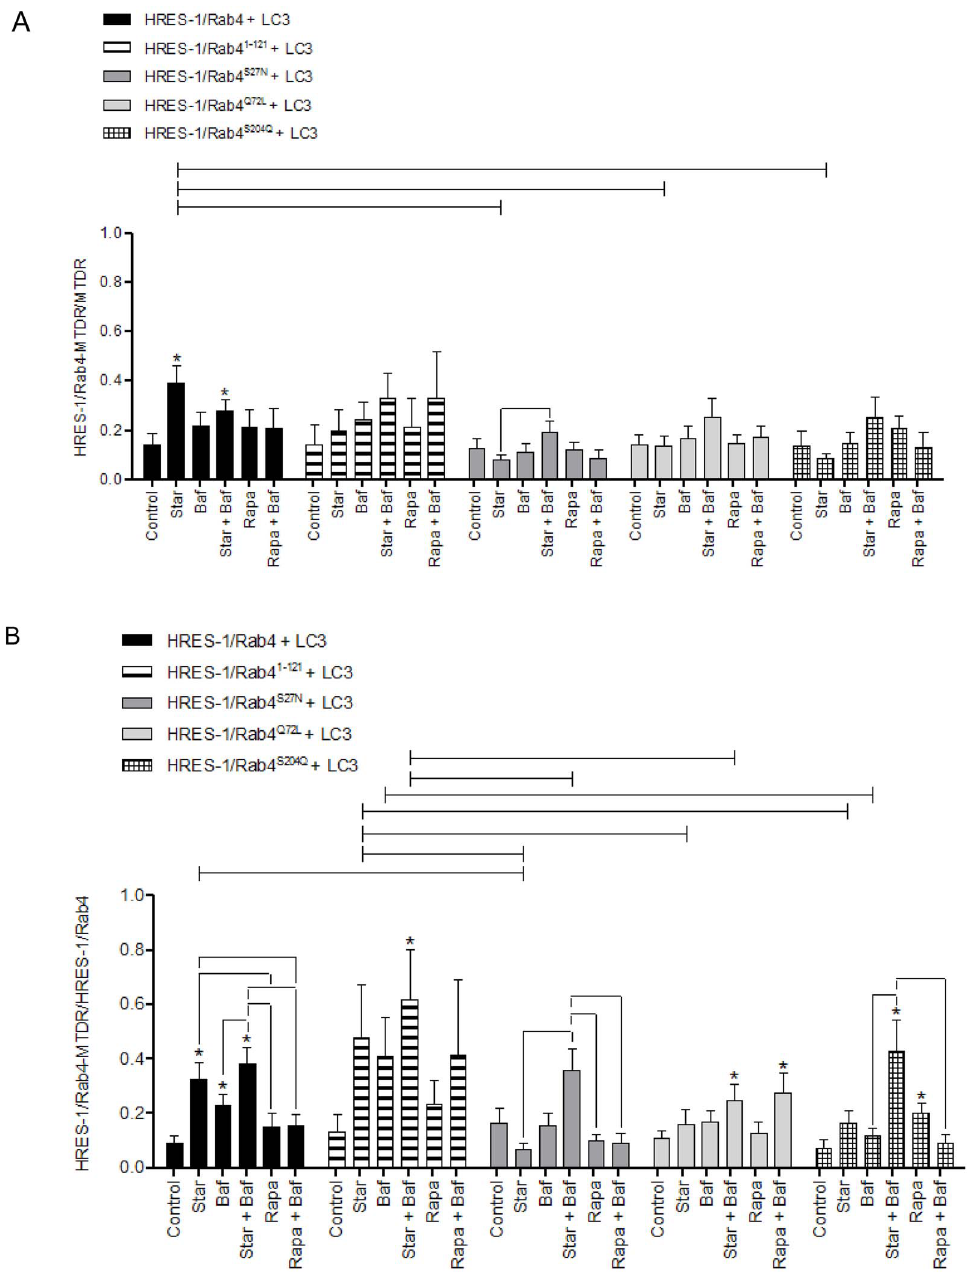
Figure 6. Quantitative analysis of colocalization between HRES-1/Rab4 and mitochondria in HeLa cells transfected with eGFP- tagged HRES-1/Rab4 isoforms and FP650-LC3. Autophagy was induced by starvation (Star) or treatment with rapamycin (Rapa) in the presence or absence of bafilomycin A1 (Baf). A, Colocalization of HRES-1/Rab4 and MTDR-stained mitochondria relative to the total mitochondrial pool. B, Colocalization of HRES-1/Rab4 and MTDR-stained mitochondria relative to the total HRES-1/Rab4 pool. Bars represent mean 6 SEM. Data represent mean 6 SEM of 6–29 cells acquired in 3 independent experiments. * indicates p values , 0.05 reflecting comparison to control cells among cell cultures transfected with the same construct using paired two-tailed t-tests; brackets connecting bars within each construct also reflect comparison with paired two-tailed t-tests. Brackets connecting bars between constructs reflect p , 0.05 using ANOVA followed by Bonferroni’s post-test.